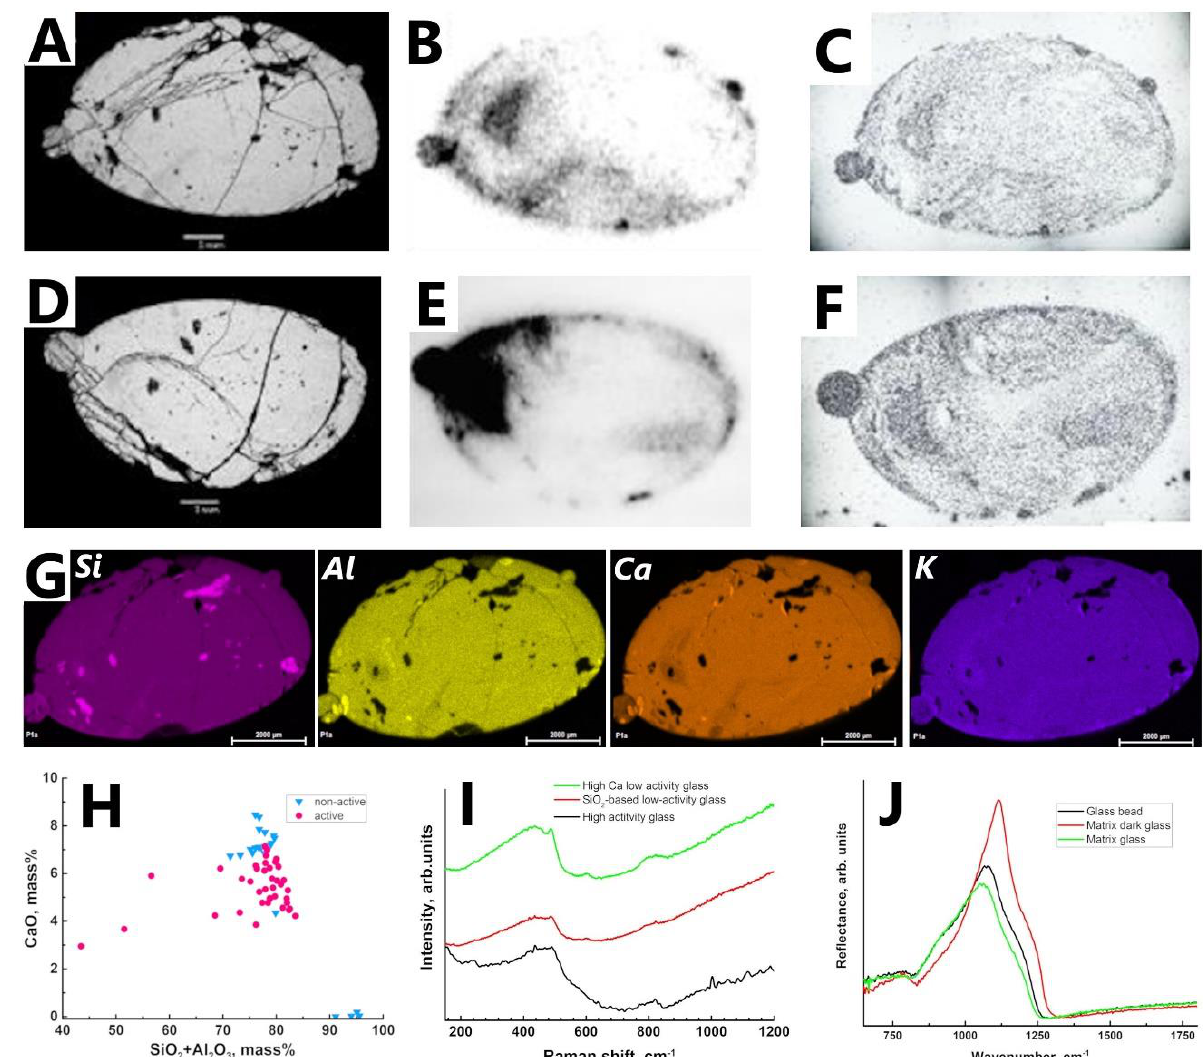
Figure 4. Structural and compositional peculiarities of both parts of the R1 aerodynamic fallout particle (R1a and R1b). ( A , D ) SEM-BSE images of R1a and R1b subsamples in epoxy; ( B , E ) α -track radiographs (19 h exposure); ( C , F ) imaging plate radiographs (2 h exposure); ( G ) micro-XRF maps of the R1a subsample: Si, Al, Ca, and K distribution; ( H ) compositional (CaO — (SiO 2 + Al 2 O 3 )) plot for regions of the glass with contrasting radioactivity levels; ( I ) Raman spectra of low- (red and green curves) and high-activity (black) glasses of the R1b; ( J ) FTIR spectra of former quartz grains (red) and representative spectra of the glassy matrix.